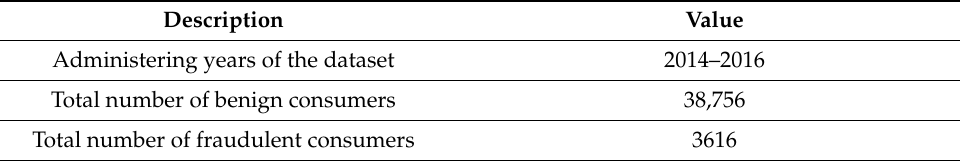
Table 2. Metadata Information of SGCC